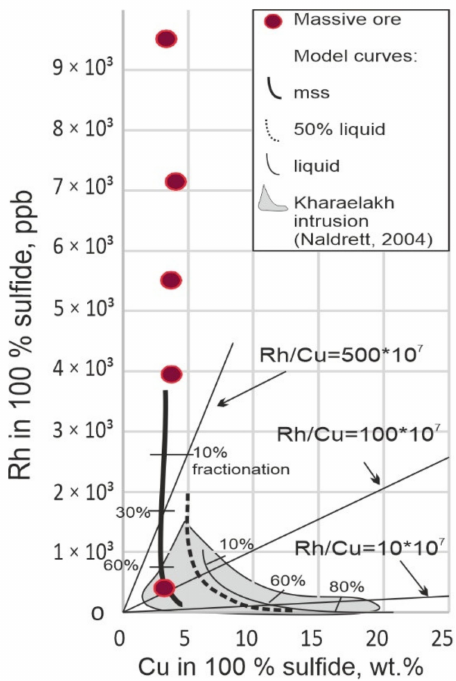
Figure 14. Variations in Rh content relative to Cu for different samples of the Skalisty mine compared with data from the Norilsk region concerning model curves of Rayleigh fractionation